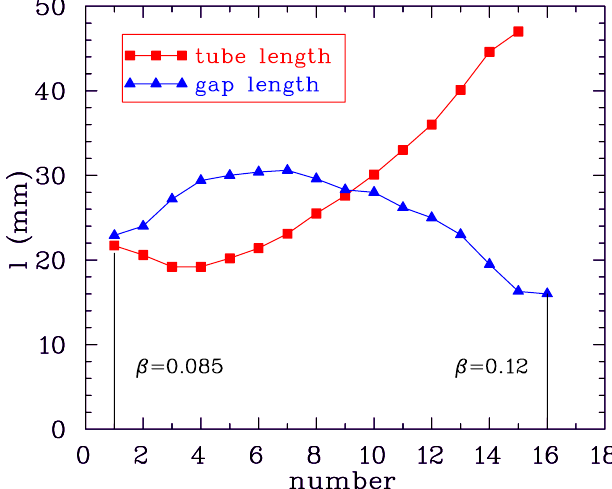
FIG. 13. (Color) Gap and drift-tube lengths which are required to obtain the flat field distribution in Fig. 12.